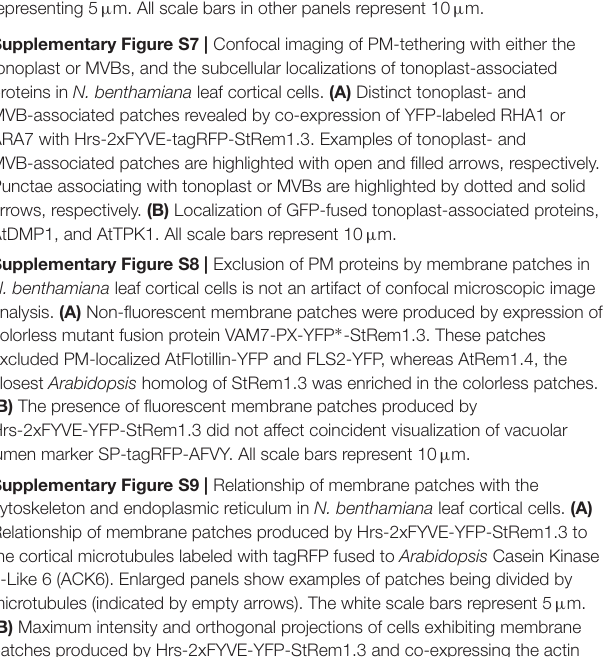
Supplementary Figure S4 | Subcellular localization of trifunctional fusion proteins expressed at different levels in N. benthamiana leaf cortical cells. (A) Trifunctional fusion proteins contained a PtdIns(3)P biosensor (VAM7-PX or Hrs-2xFYVE), fused to YFP or tagRFP and also to StRem1.3, in that order from N-terminus to C-terminus. Expression of these fusion proteins in N. benthamiana cells produced membrane patches without the use of BiFC. The membrane patches in bigger sizes are highlighted by the solid circles, and vice versa for the dotted circles. (B) Expression level determines the sizes of patches produced by trifunctional fusion protein VAM7-PX-YFP-AtRem1.4. Expression was driven by either the native promoter ProAtRem1.4 or the highly active CaMV35S promoter. Dashed boxes indicate regions enlarged in the top layer views shown in the center panels. Mutations in the PtdIns(3)P binding site of VAM7-PX ∗ -YFP-AtRem1.4 abolishes the formation of patches with either promoter. (C) Subcellular localization of AtRem1.4 fused with YFP. (D) Quantitative Real-Time PCR assay of the transcript levels of fusion constructs in (B) above. The experiments were replicated three times independently. All data were normalized relative to the transcript level of the internal reference gene EF1a . Error bars represent s.e. (E) Fluorescence distribution of VAM7-PX-YFP-AtRem1.4 and VAM7-PX ∗ -YFP-AtRem1.4 produced by expression driven by the native promoter ProAtRem1.4 in transgenic Arabidopsis lines. The scale bars in (A–E) represent 10 µ m. Supplementary Figure S5 | Subcellular localizations of wildtype and mutant plasma membrane proteins including PtdIns(4)P biosensors in N. benthamiana leaf cortical cells. (A) Localization of YFP-fused peripheral membrane proteins, BIK1, PBS1, and CPK21, and PtdIns(4)P biosensors, FAPP1a and Osh2p. (B) Localization of YFP-fused mutant versions of PM proteins and PtdIns(4)P biosensors (StRem1.3 ∗ , BIK1 ∗ , and FAPP1a ∗ ) carrying mutations in residues required for binding to the PM or to PtdIns(4)P respectively. (C) Localization of BiFC complexes formed by co-expression of PM-non-binding mutants VenusN-StRem1.3 ∗ , BIK1 ∗ -VenusN or FAPP1a-PH ∗ -VenusN with either VenusC-VAM7-PX or VenusC-Hrs-2xFYVE. (D) Localization of BiFC complexes formed by co-expression of VenusN-fused PtdIns(4)P-binding protein Osh2p together with VenusC-fused VAM7-PX or Hrs-2xFYVE. The scale bar represents 10 µ m in all panels. Supplementary Figure S6 | Subcellular localizations of proteins associated with MVBs and the tonoplast in N. benthamiana leaf cortical cells. Rab5-type GTPases RHA1, ARA7, and ARA6, and Rab7-type GTPase RABG3f were fused with YFP. Dashed boxes indicate regions enlarged in bottom panels with the scale bar representing 5 µ m. All scale bars in other panels represent 10 µ m. Supplementary Figure S7 | Confocal imaging of PM-tethering with either the tonoplast or MVBs, and the subcellular localizations of tonoplast-associated proteins in N. benthamiana leaf cortical cells. (A) Distinct tonoplast- and MVB-associated patches revealed by co-expression of YFP-labeled RHA1 or ARA7 with Hrs-2xFYVE-tagRFP-StRem1.3. Examples of tonoplast- and MVB-associated patches are highlighted with open and filled arrows, respectively. Punctae associating with tonoplast or MVBs are highlighted by dotted and solid arrows, respectively. (B) Localization of GFP-fused tonoplast-associated proteins, AtDMP1, and AtTPK1. All scale bars represent 10 µ m. Supplementary Figure S8 | Exclusion of PM proteins by membrane patches in N. benthamiana leaf cortical cells is not an artifact of confocal microscopic image analysis. (A) Non-fluorescent membrane patches were produced by expression of colorless mutant fusion protein VAM7-PX-YFP ∗ -StRem1.3. These patches excluded PM-localized AtFlotillin-YFP and FLS2-YFP, whereas AtRem1.4, the closest Arabidopsis homolog of StRem1.3 was enriched in the colorless patches. (B) The presence of fluorescent membrane patches produced by Hrs-2xFYVE-YFP-StRem1.3 did not affect coincident visualization of vacuolar lumen marker SP-tagRFP-AFVY. All scale bars represent 10 µ m. Supplementary Figure S9 | Relationship of membrane patches with the cytoskeleton and endoplasmic reticulum in N. benthamiana leaf cortical cells. (A) Relationship of membrane patches produced by Hrs-2xFYVE-YFP-StRem1.3 to the cortical microtubules labeled with tagRFP fused to Arabidopsis Casein Kinase 1-Like 6 (ACK6). Enlarged panels show examples of patches being divided by microtubules (indicated by empty arrows). The white scale bars represent 5 µ